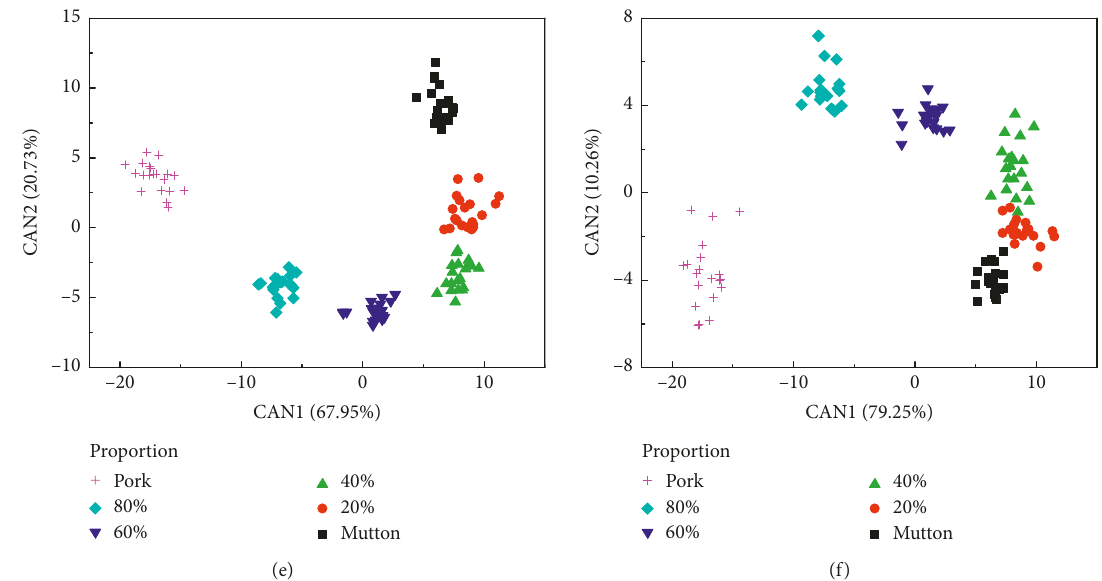
Figure 3: Scatter plot of CDA with linear discriminant function: (a) E-tongue; (b) E-nose; (c) original sensor fusion of E-tongue and E-nose; (d) features extracted by stepwise LDA on original sensor fusion data; (e) combination of features of E-nose and E-tongue extracted by PCA; (f) features extracted by PCA on original sensor fusion